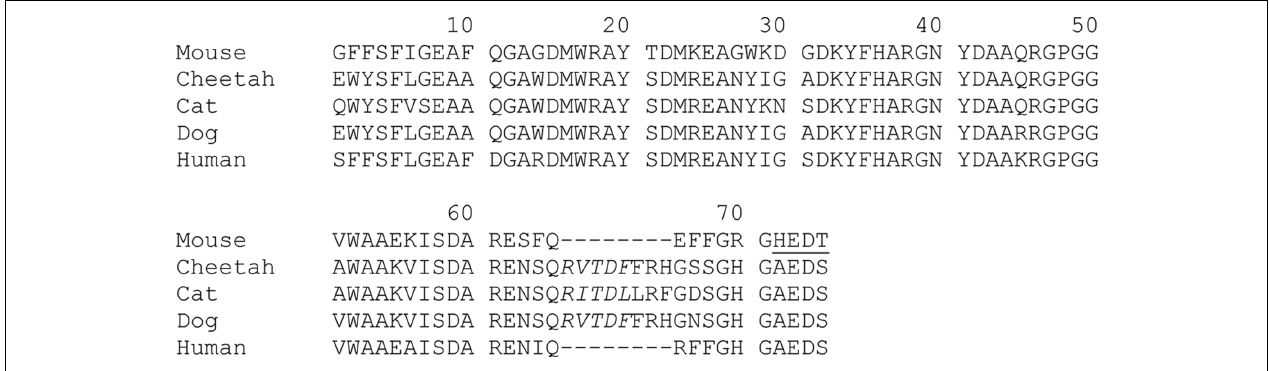
FIGURE 1 |Amino acid sequences ofAA amyloid from five mammalian species. The five-residue murine C-terminal AA peptide, GHEDT, spanning residues 71–75 and used as immunogen to generate mAbs 2A4, 7D8, and 8G9 is underlined (the cheetah, cat, and dog proteins contain an 8-amino acid insertion between positions 65 and 66).